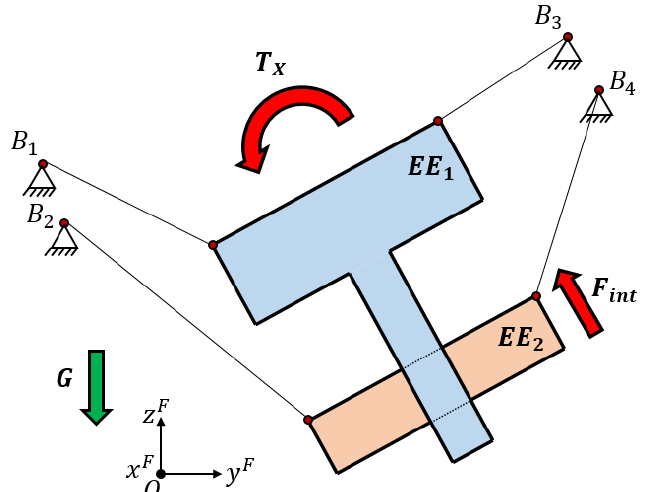
Figure 1. Schematic description of a planar suspended cable-driven parallel robot (CDPR) with reconfigurable end effector (EE) actuated by simple cables. It is seen that when a torque is imposed on the entire end effector, it appears as an internal force in the second body of the end effector, making the control of all degrees of freedom (dof) of one of the bodies difficult.